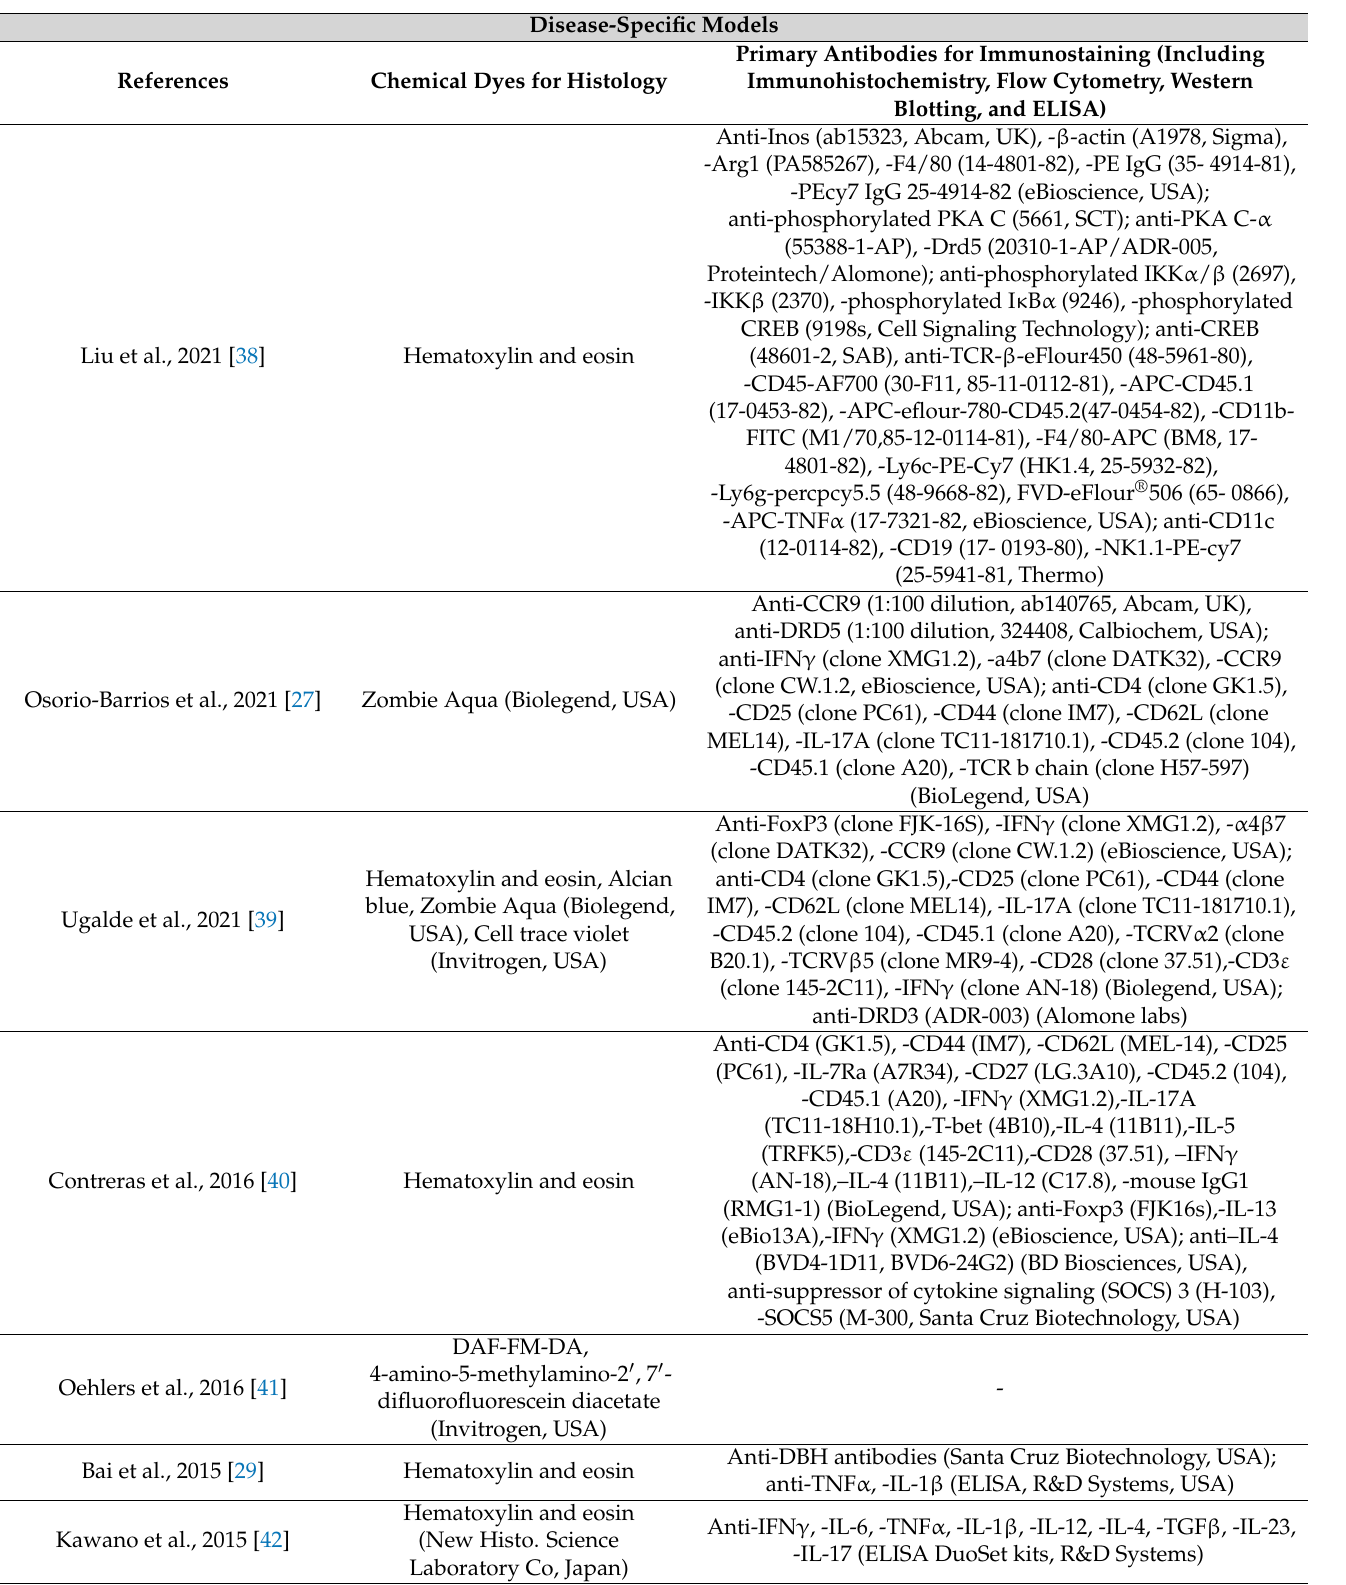
Table 4. Dyes and antibodies used for in vivo and in vitro histological analysis and/or immunostaining (immunohisto- chemistry, immunoblotting, flow cytometry, enzyme-linked immunosorbent